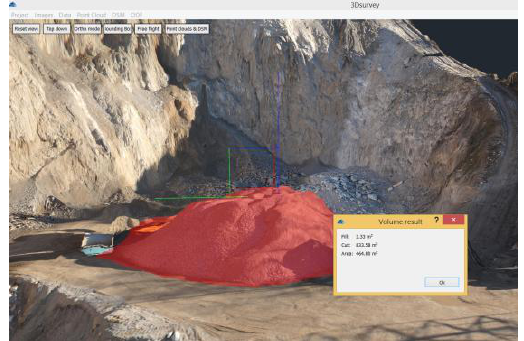
Figure 5: Calculation of volumes in software 3Dsurvey (Kosmatin Fras et al., 2015)